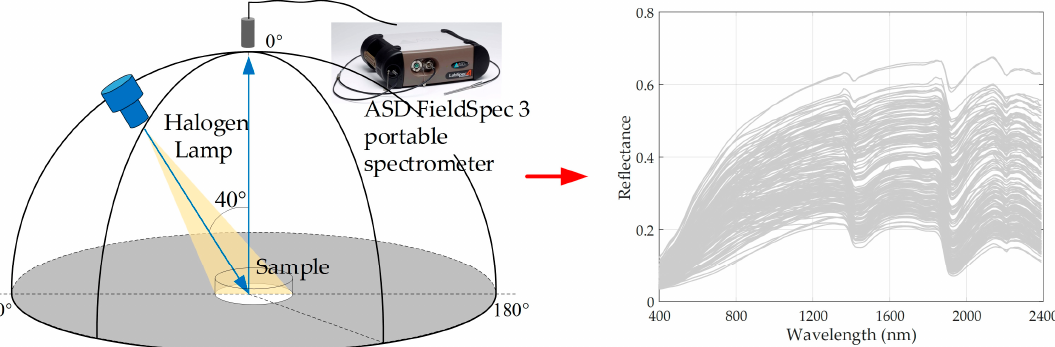
Figure 7. Experimental equipment and measured soil reflectance data.